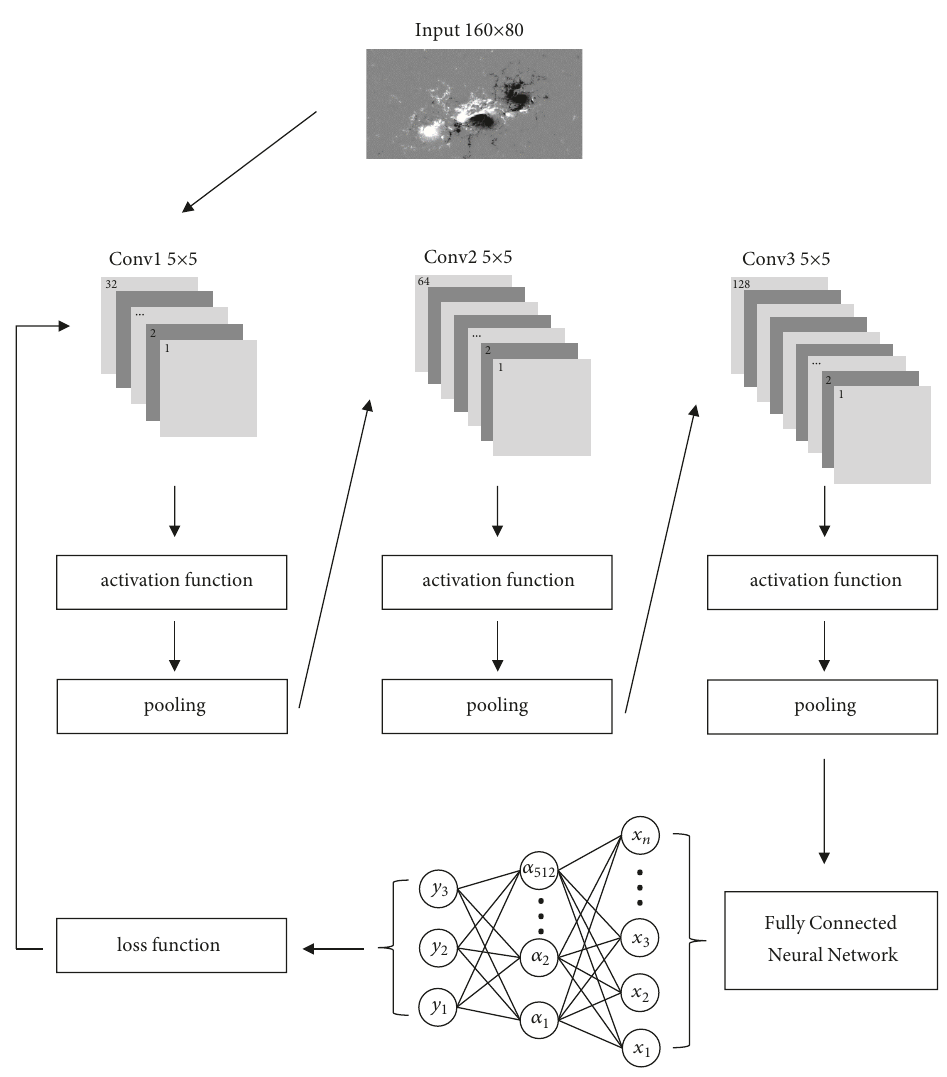
Figure 2: A schematic of the CNN